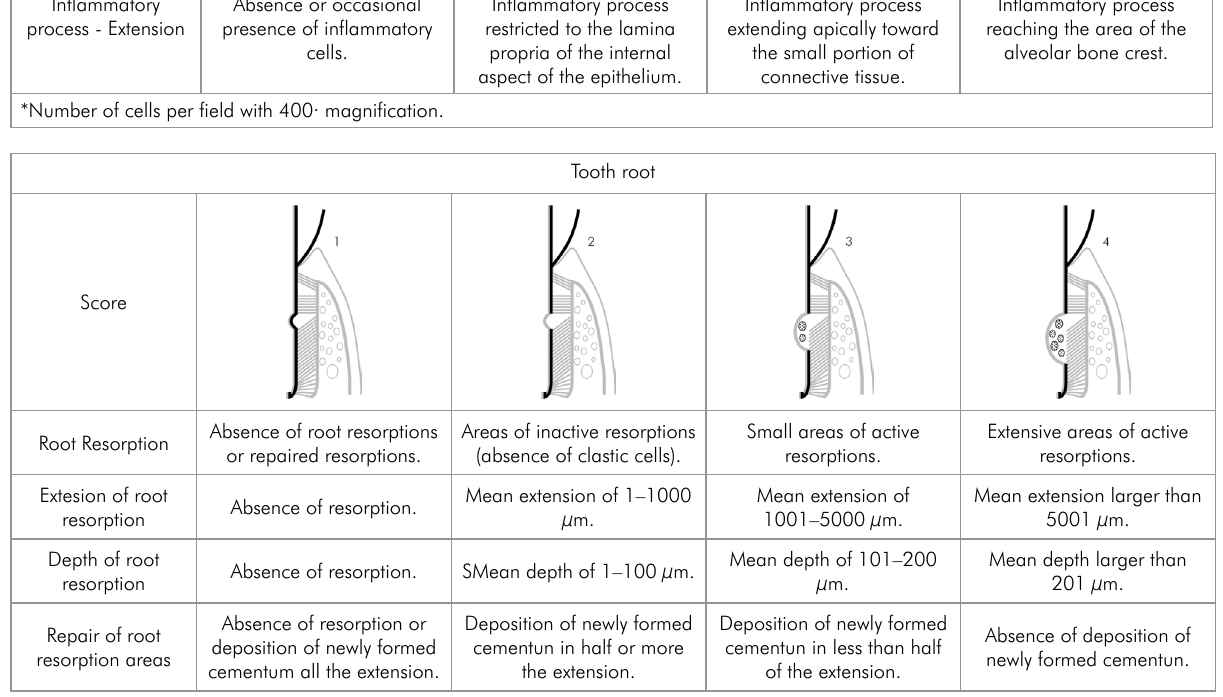
Figure 1. Scores used in the quantification of histological